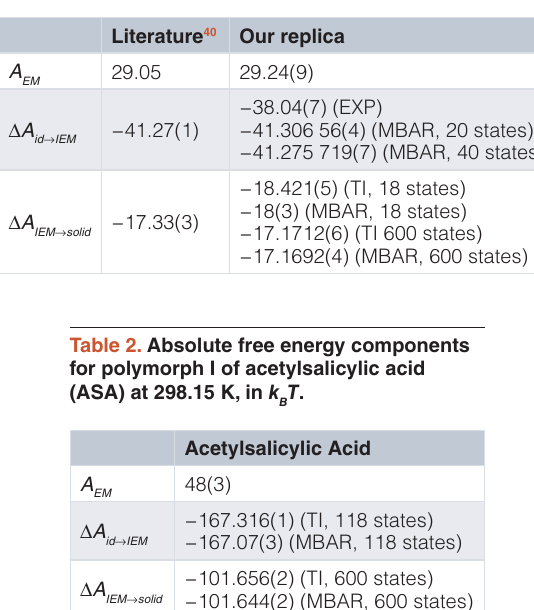
Table 1. Absolute free energy components for α -methanol at 150 K, in k T . B